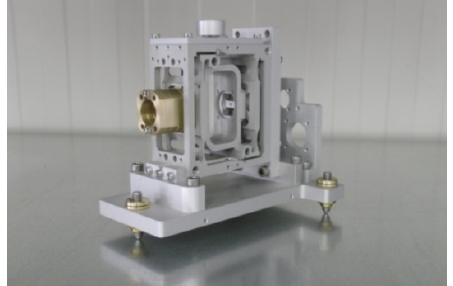
Figure 4. Uniaxial monolithic UNISA Folded Pendulum (Model GE15)